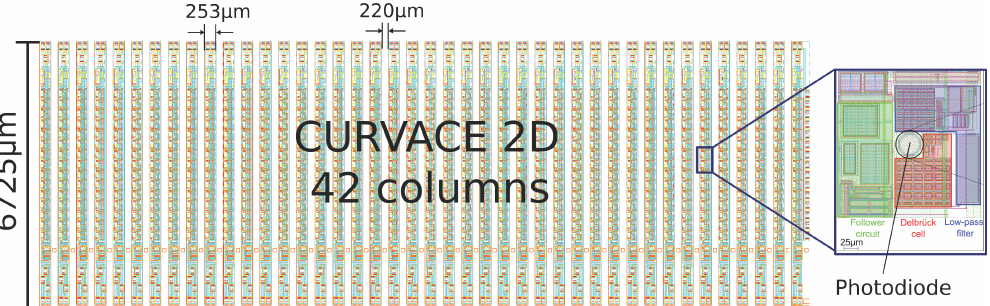
Figure 2. Layout of the sensor die fabricated by means of a CMOS 0 . 35 µm process (XFAB opto